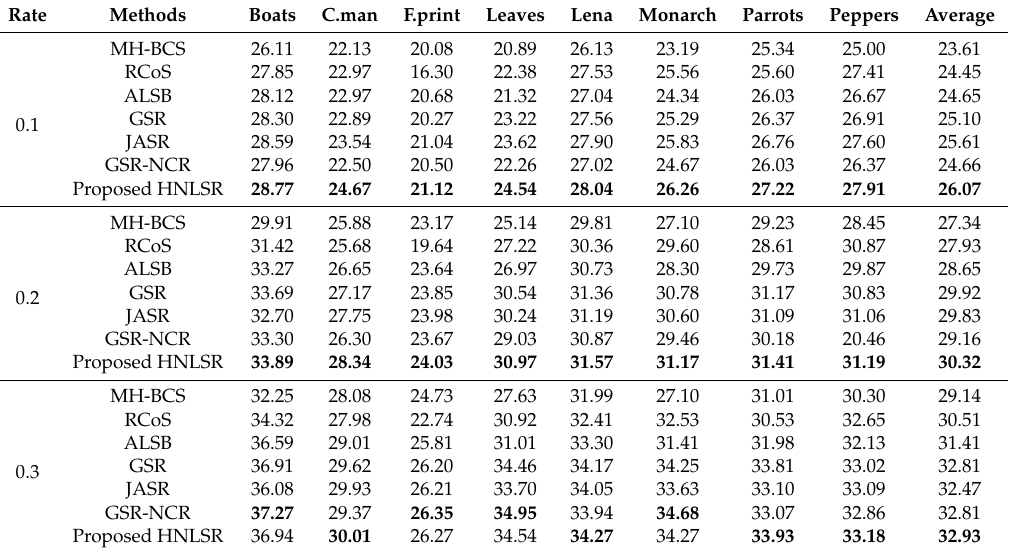
Table 1. PSNR(dB) comparison of six representative methods and the proposed method. Rate Methods